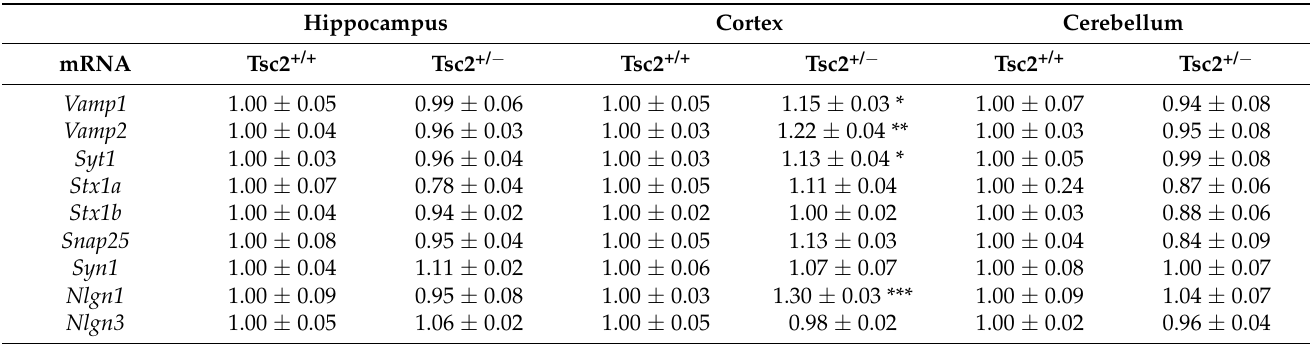
Table 1. The effect of Tsc2 haploinsufficiency on the mRNA levels for synaptic proteins. Hippocampus Cortex Cerebellum